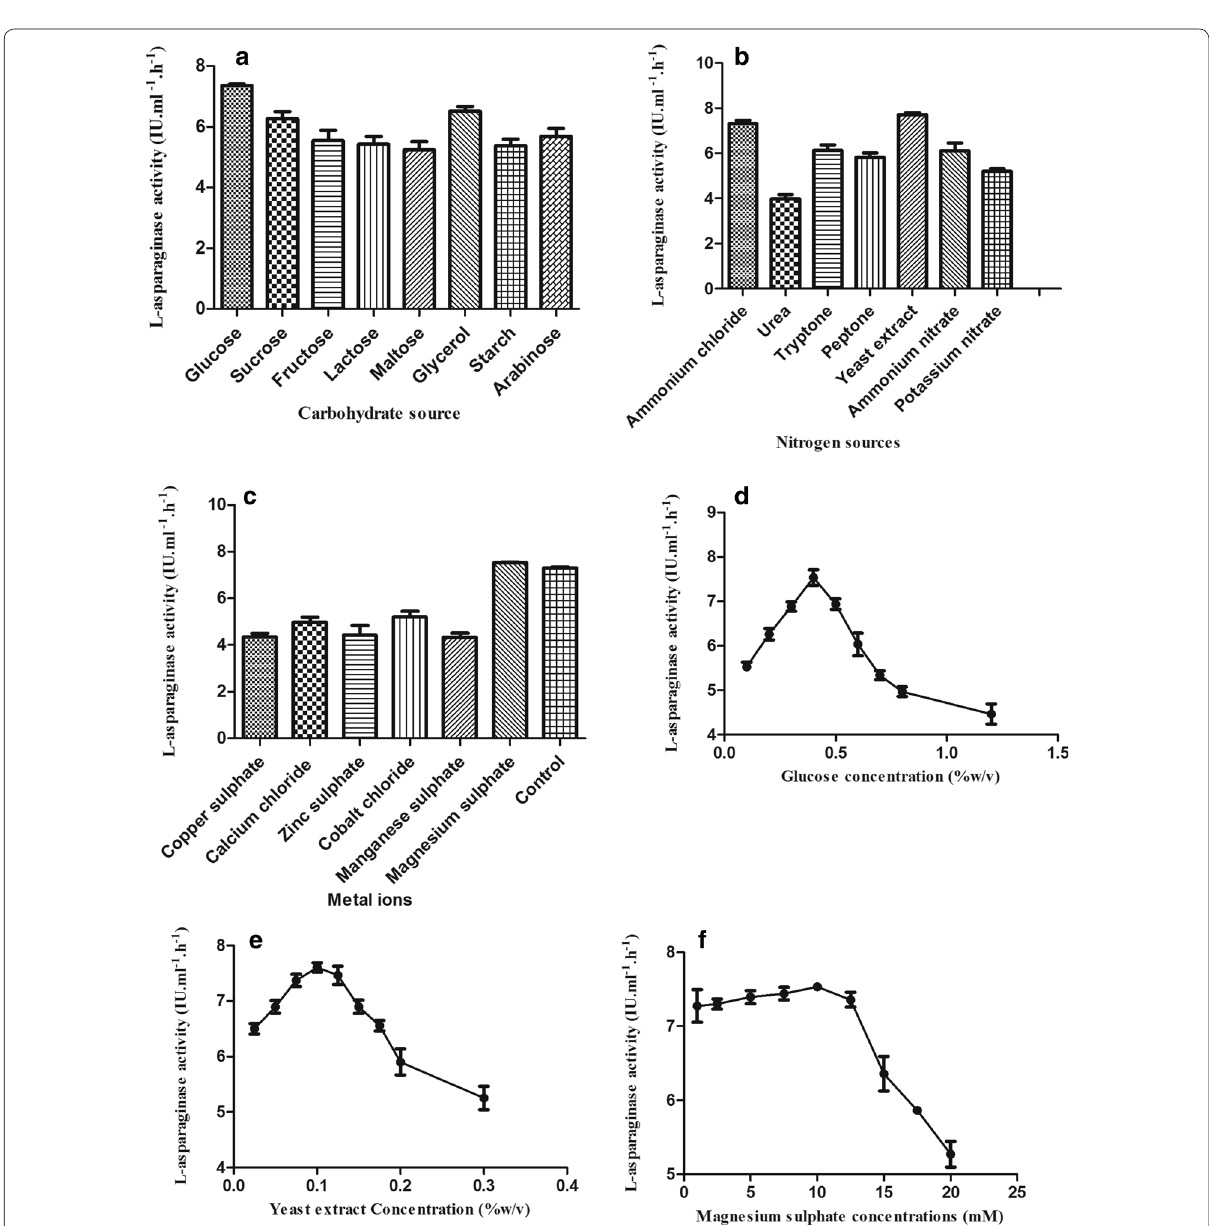
Fig. 6 l -asparaginase production by Stenotrophomonas maltophilia EMCC2297 variant at various sources of a carbohydrate, b nitrogen, c metal salts and various concentrations of d dextrose, e yeast extract and f sulphate salt of magnesium. In all cases ( a – f ) p-values were < 0.0001 which indicates high significance of the